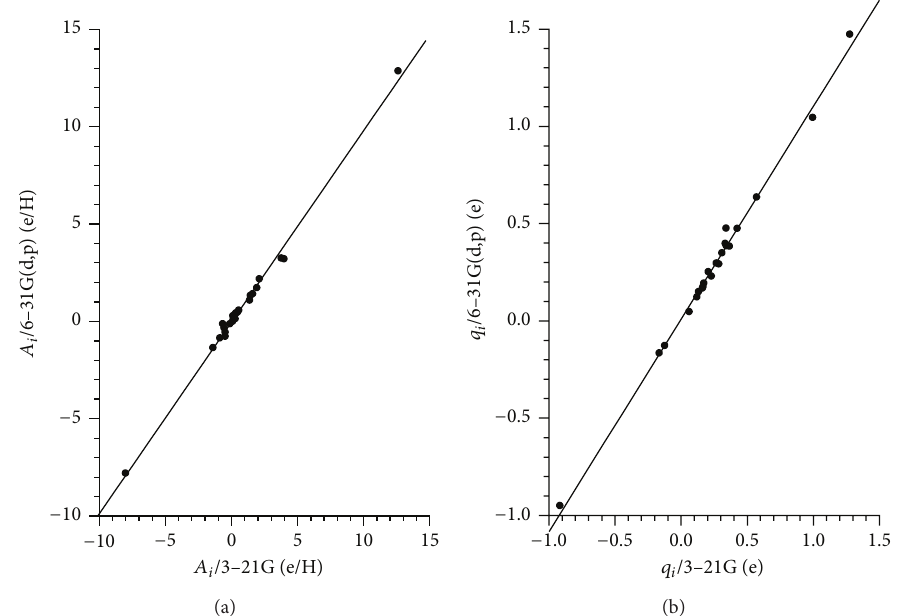
Figure 2: Correlation of BPT/NPA parameters using different compact basis sets. (a) Correlation of 𝐴 𝑖 /3-21G and 𝐴 𝑖 /6-31G(d,p) with 𝑅 = 0.9969 and SD = 0.26 e/H. (b) Correlation of 𝑞